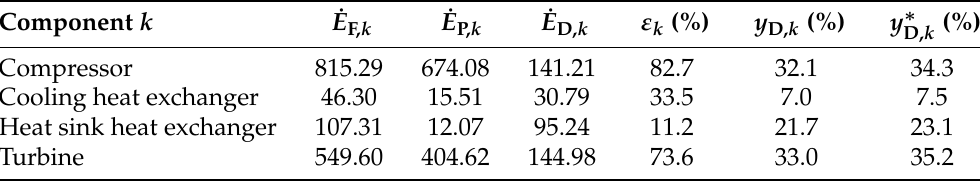
Table 10. Air refrigeration cycle—Results of the exergy analysis, components. If not given, dimension of data is